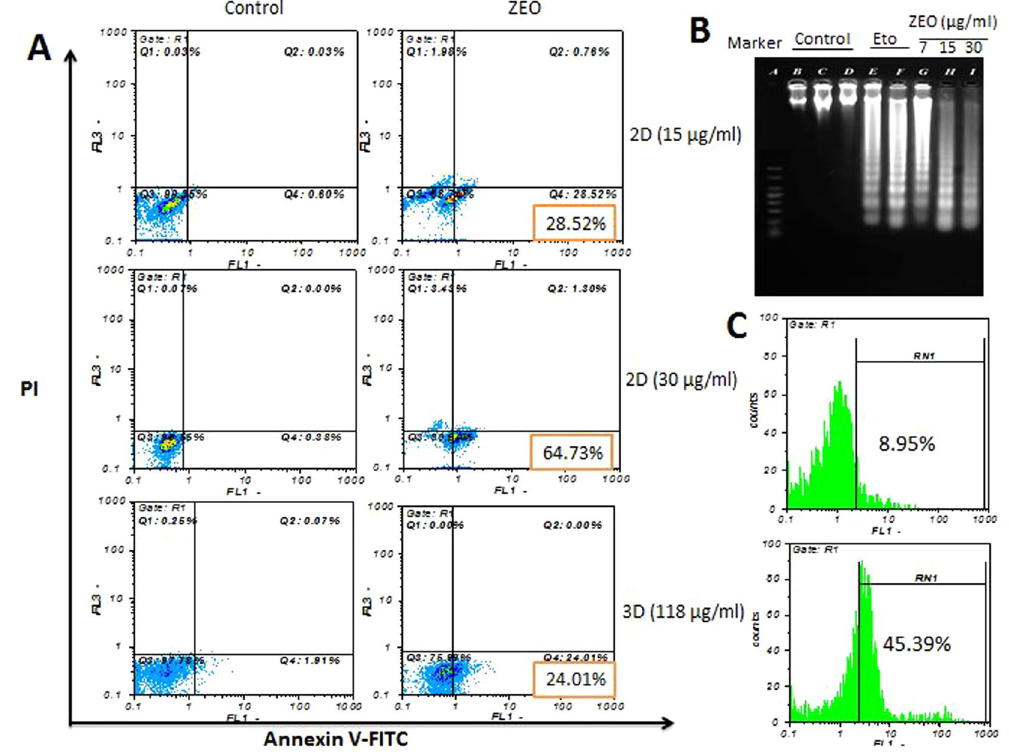
Figure 4. ZEO induces apoptosis in MDA-MB-231 cells 2D and 3D cell cultures. ( A ) Flow cytometry Scattergram of apoptosis and necrosis assay (Annexin V-FITC/PI) in MDA-MB-231 cells 2D and 3D cultures. In each panel, the lower left quadrant shows cells negative for both PI and Annexin V-FITC, upper left shows only PI necrotic cells, the lower right quadrant shows Annexin positive cells which are in the early apoptotic stage and the upper right shows both Annexin/PI positive, which are in the late apoptosis/necrosis stage. In all of the control samples more than 97% of the cells were live with intact cell membranes. While monolayer cultured samples treated with ZEO displayed considerable cytotoxicity and 27%(15 μ g/ml), 64%(30 μ g/ml) of their cells were in early apoptotic phase, 76% of the cells in 3D tumor spheroids treated with ZEO were alive with intact cell membrane and only 22% of the cells were in early apoptotic stage. ( B ) DNA fragmentation analysis on agarose gel. DNA was isolated from monolayer cultured MDA-MB-231 cells, treated for 7 h with 7, 15 and 30 μ g/ml of ZEO and etoposide (positive control), electrophoresis was performed in 2% agarose gel, followed by Ethidium bromide staining. ( C ) TUNEL assay flow cytometric histograms of MDA-MB-231 cells treated with ZEO IC50 for 4 h and untreated control. An evident shift of the cell population (45.39%) to the right compared to control (8.95%) indicates a significant apoptotic cell population in ZEO treated